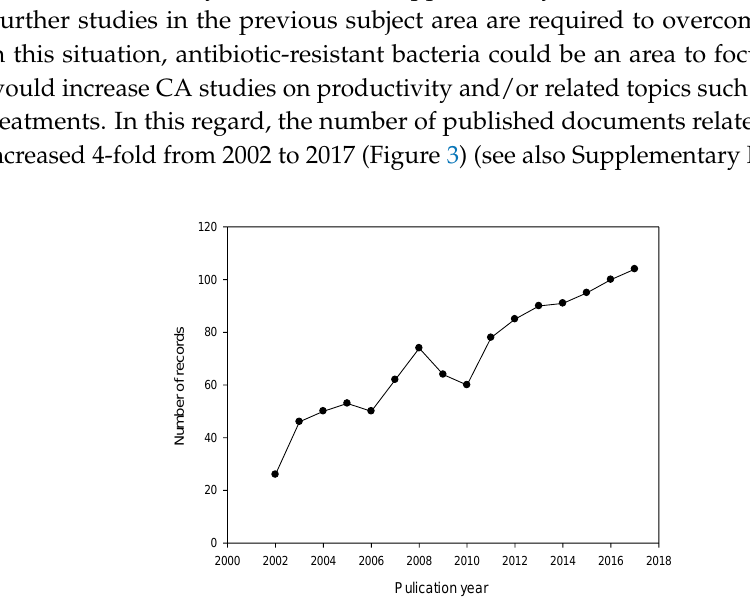
Figure 3. Records of amoxicillin-clavulanic acid (CA) resistance studies between 2002 and 2017.